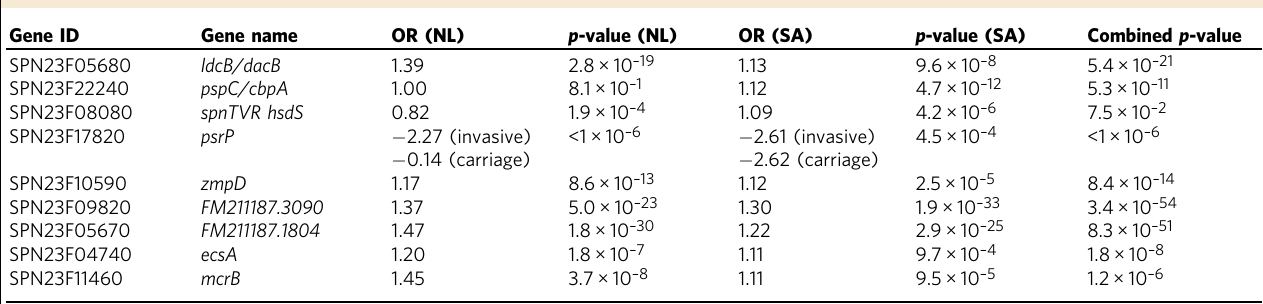
Table 3 Meta-analysis of signals of bacterial